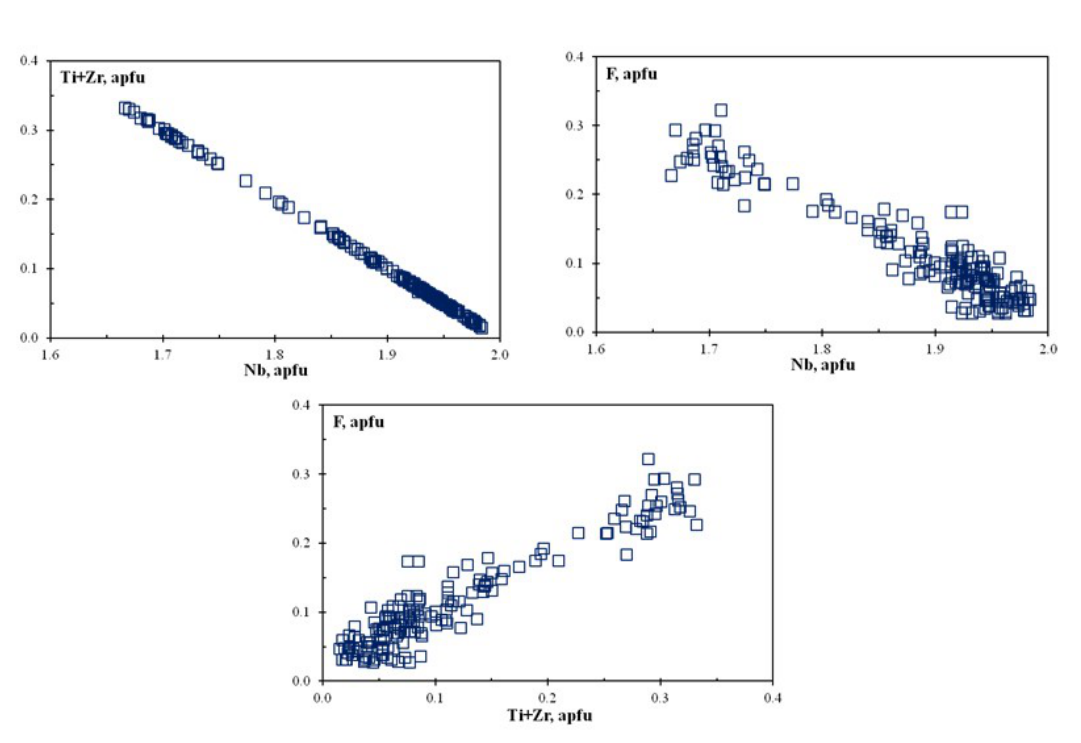
Figure 7. Compositional variations of rippite (in